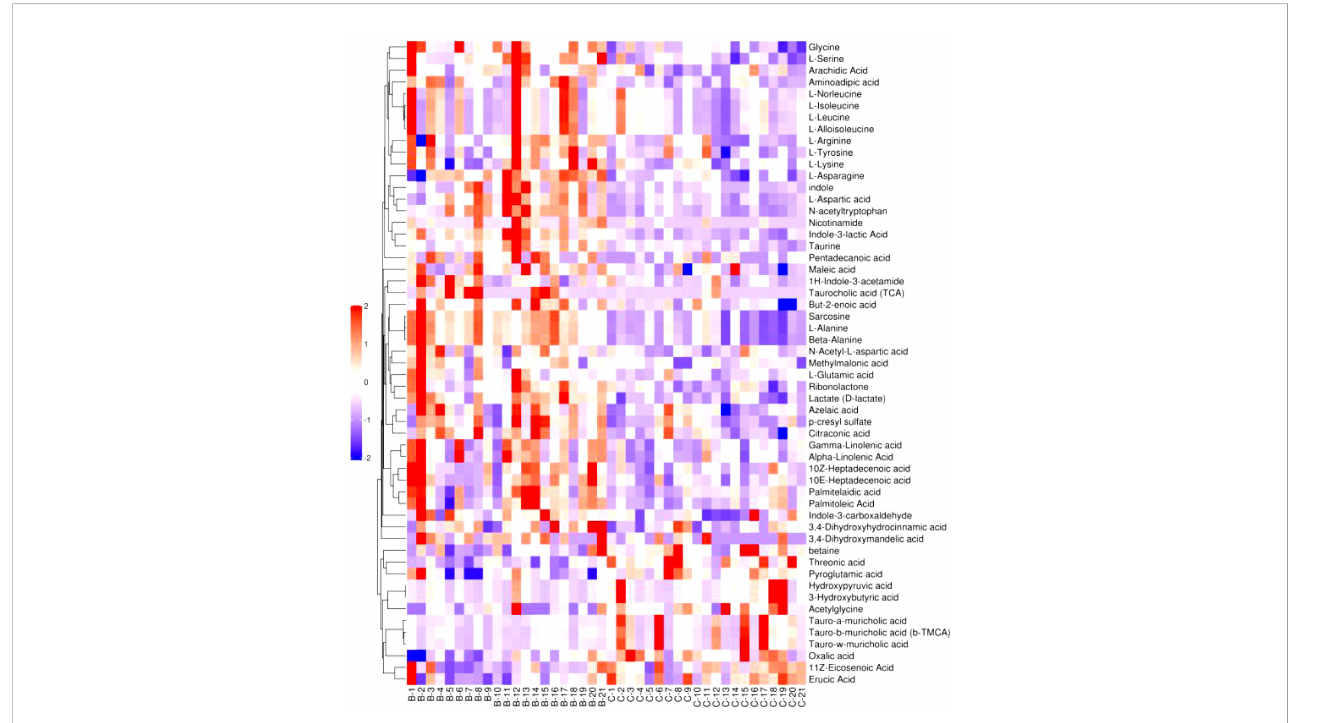
FIGURE 8 Heatmap of metabolites hierarchically clustered for signi fi cant differences between placebo and normal controls.